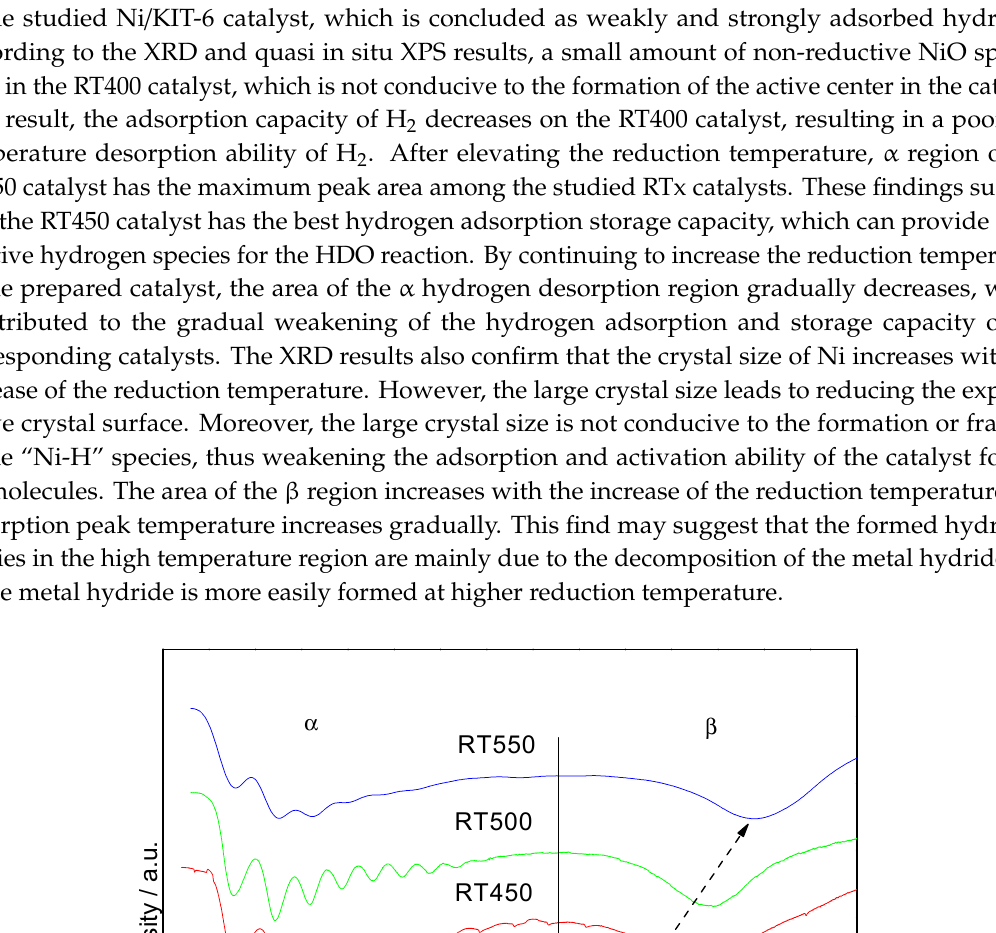
Figure 4. H 2 -TPD patterns of RTx catalysts. (x = 400, 450, 500, and 550).